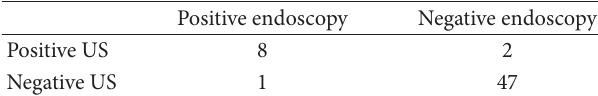
Table 3: A 2 × 2 table for ultrasound compared to gold standard